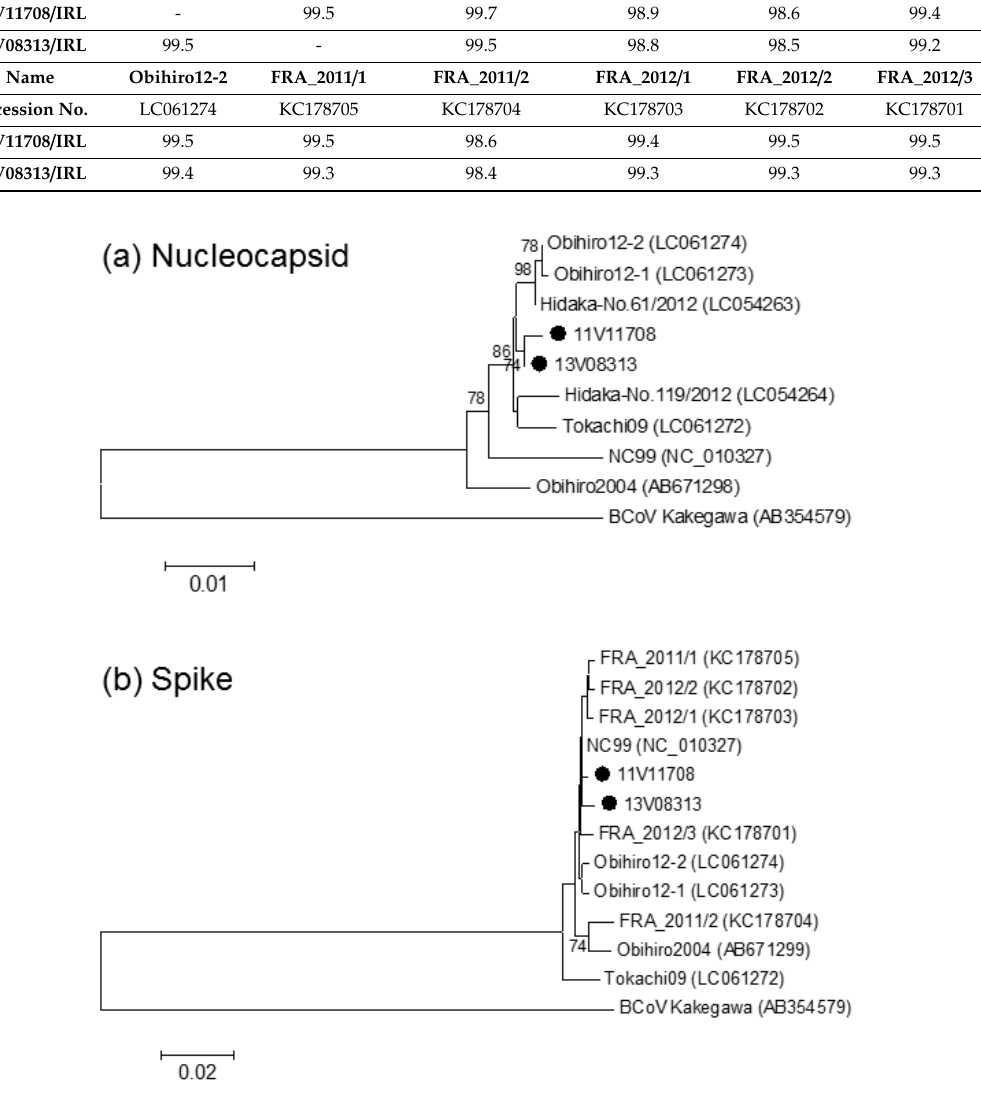
Figure 1. Phylogenetic analysis of the nucleotide sequences of the complete nucleocapsid ( a ) and the partial spike ( b ) genes of equine coronavirus. Closed circles indicate two of the equine coronaviruses detected in Ireland (11V011708 and 13V03813). The percentage bootstrap support is indicated by the value at each node; values < 70% are omitted. Scale bars indicate nucleotide substitutions per site. BCoV (Bovine coronavirus) Kakegawa strain is used as an out-group.